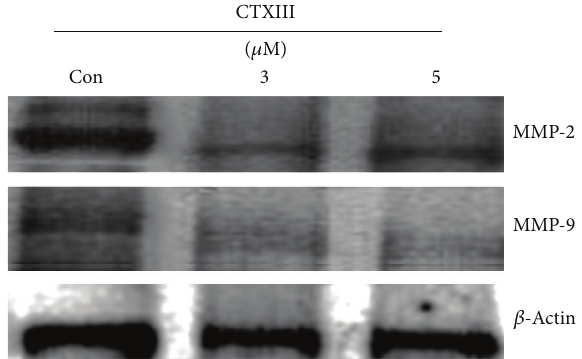
Figure 3: The regulation of MMP-2 and -9 expressions by CTXIII. Ca9-22 cells were treated with vehicle control, 3 and 5 𝜇 g/mL of CTXIII for 24 h, respectively. Two major prometasta- sis associated extracellular matrix metalloproteinases MMP-2 and MMP-9 were examined using the Western blot assay. 𝛽 -Actin was used as an internal control. Each representative blot was performed in at least triplication.